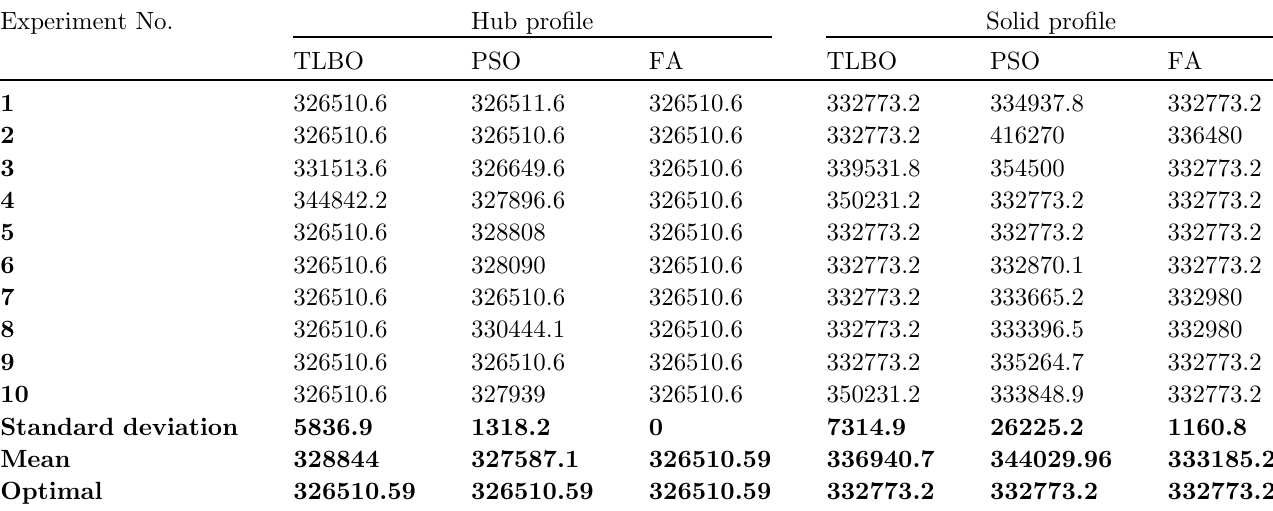
Table 3. Volume (mm 3 ) experimentation results for hub-pro fi le and solid-pro fi le. Experiment